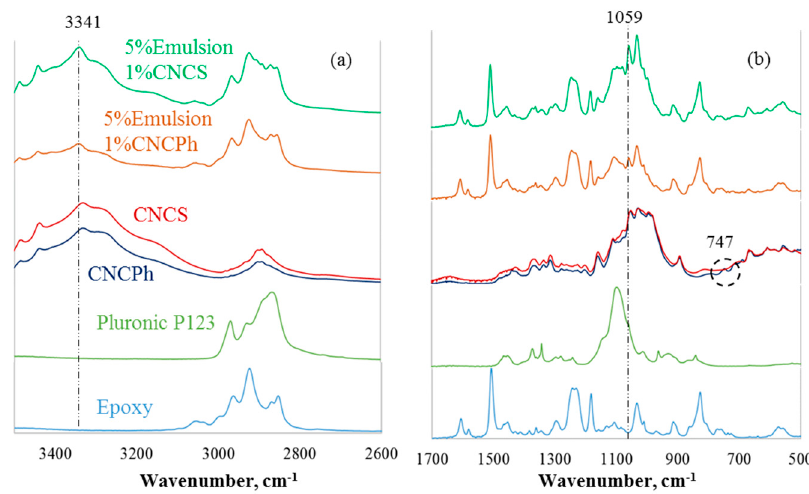
Figure 2. FTIR spectra ( a ) 3500 to 2700 cm − 1 , ( b ) 1800 cm − 1 to 500 cm − 1 of CNC films and dried dispersions.